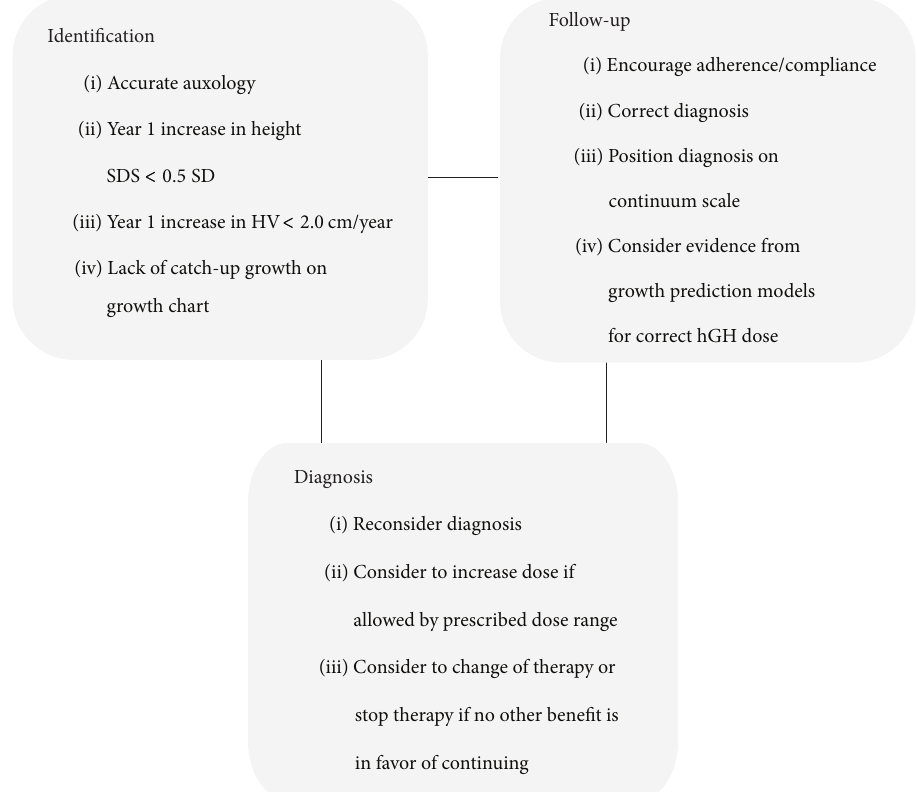
Figure 3: Identification, prevention, and management of poor response to growth hormone therapy. Bang et al. [15]. SDS: standard deviation score; SD: standard deviation; HV: height velocity; hGH: human growth